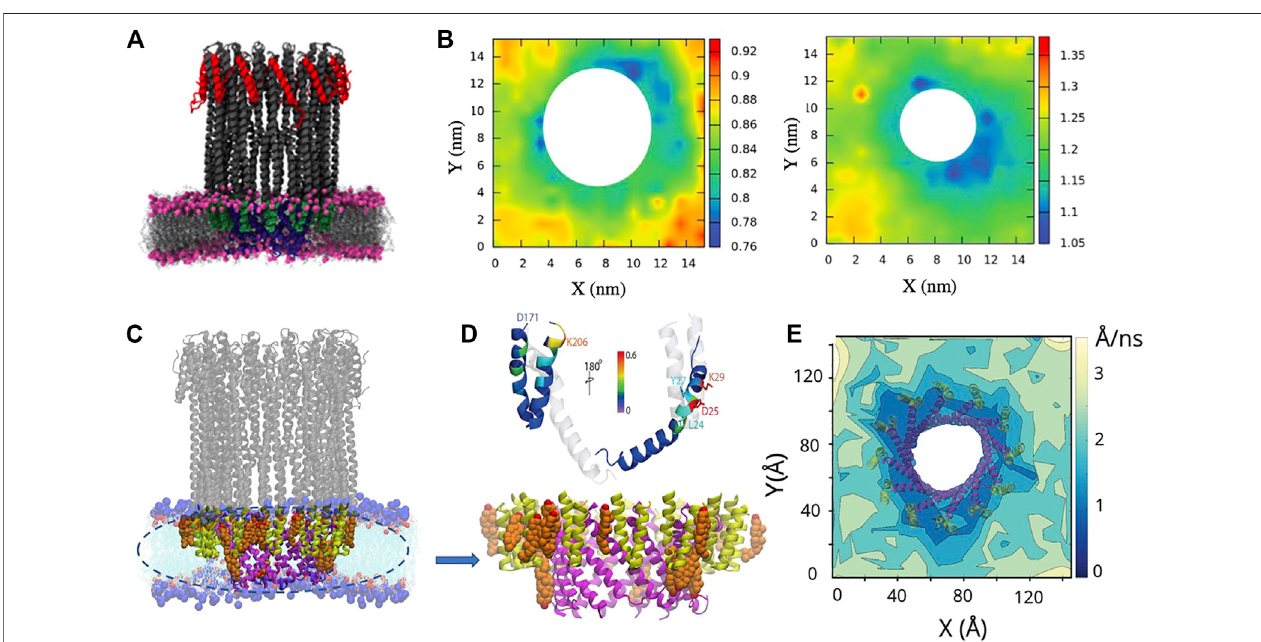
FIGURE 12 | Results from all atom MD simulations of the dodecameric ClyA pore complex. (A) Snapshot of the ClyA pore in a pure DMPC bilayer. (B) Particle displacement maps ( Δ t (cid:1) 50 ns) of the extracellular (left) and cytosolic lea fl et (right) . Increased lipid fl uidity is observed in the cytosolic lea fl et. Color bars are in units of nm. (C) Snapshot of the ClyA pore in a DOPC:Chol (70:30) membrane. Cholesterol (orange) with OH groups (red), membrane inserted β tongues (green), membrane inserted α helices (pink), lipids (cyan). (D) Cholesterol binding sites on the membrane inserted β tongue, helix-loop-helix motif and the N terminus α helix (top) . Expanded view of the membrane inserted portion of the ClyA pore illustrating cholesterol binding sites located between two membrane inserted α helices (bottom) . (E) Cholesterol mobility map ( Δ t (cid:1) 1 ns) illustrating the lowered dynamics of cholesterol in the vicinity of the pore complex. (A,B) Reproduced from Varadarajan et al., 2020; (C-E) Reproduced from Sathyanarayana et al.,